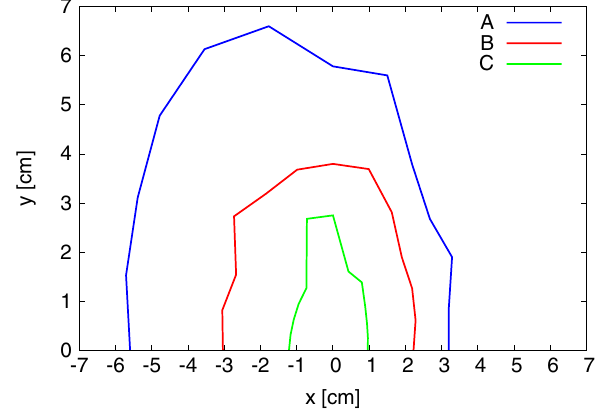
FIG. 18. Dynamic aperture plots corresponding to points A, B, and C in Fig. 17, as indicated by the color.